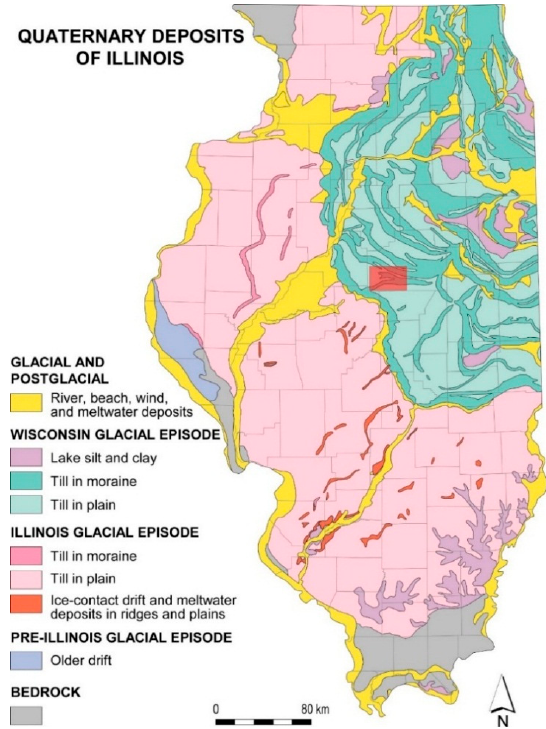
Figure 1. Surficial geologic map of Illinois showing the distribution of Quaternary glacial deposits. The area portrayed in Figure 2 is indicated by the blue box. Map is modified from: ISGS Staff, 2005, Quaternary deposits: Illinois State Geological Survey, ISGS 8.5 × 11 map series.